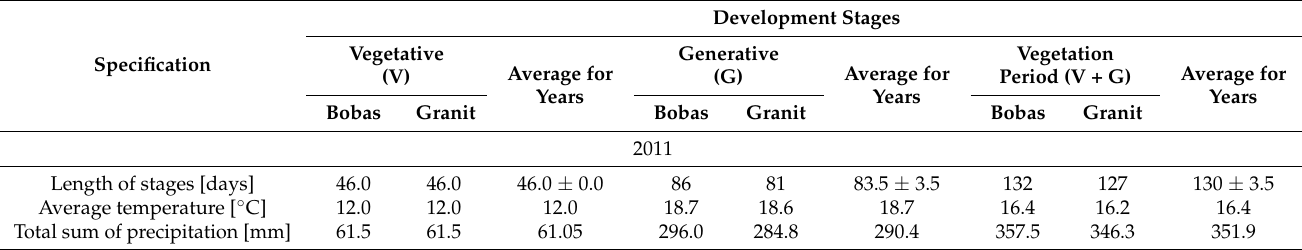
Table 4. Effect of weather conditions on faba bean development stages in the years 2011–2013.